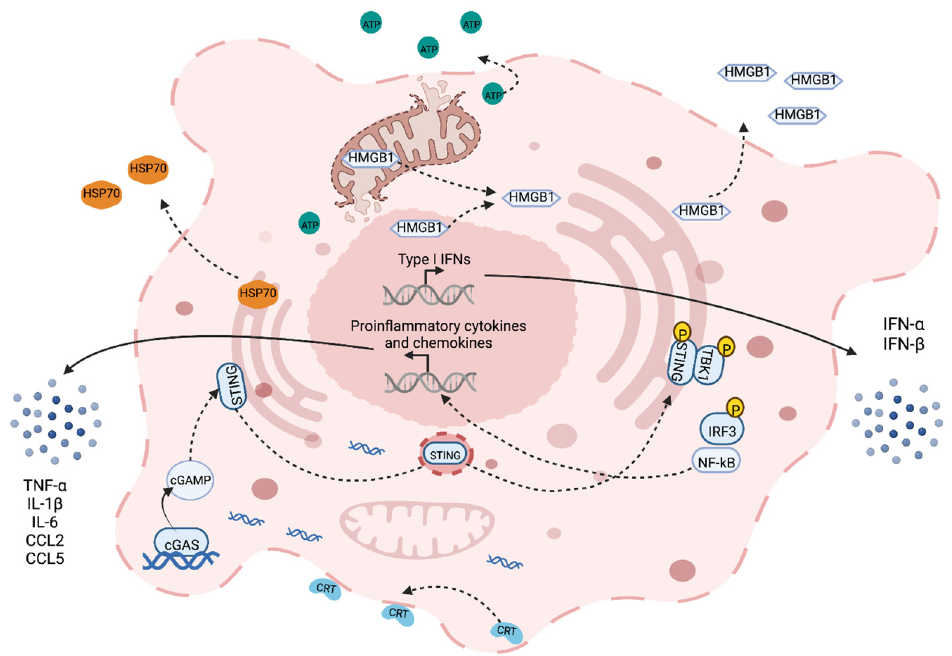
Figure 1. Immunogenic cell death elicited by IR. ICD induced by IR is marked by the release of DAMPs (HMGB1, double-stranded DNA and RNA, HSP70, ATP and calreticulin (CRT)), Type I IFN (IFN- α and IFN- β ) through cGAS-STING signaling and other cytokines (TNF- α , IL-1ß and IL-6) and chemokines (CCL2 and CCL5) through STING-induced NF- κ B activation. Broken lines indicate movement and continuous lines represent the production of the given target.